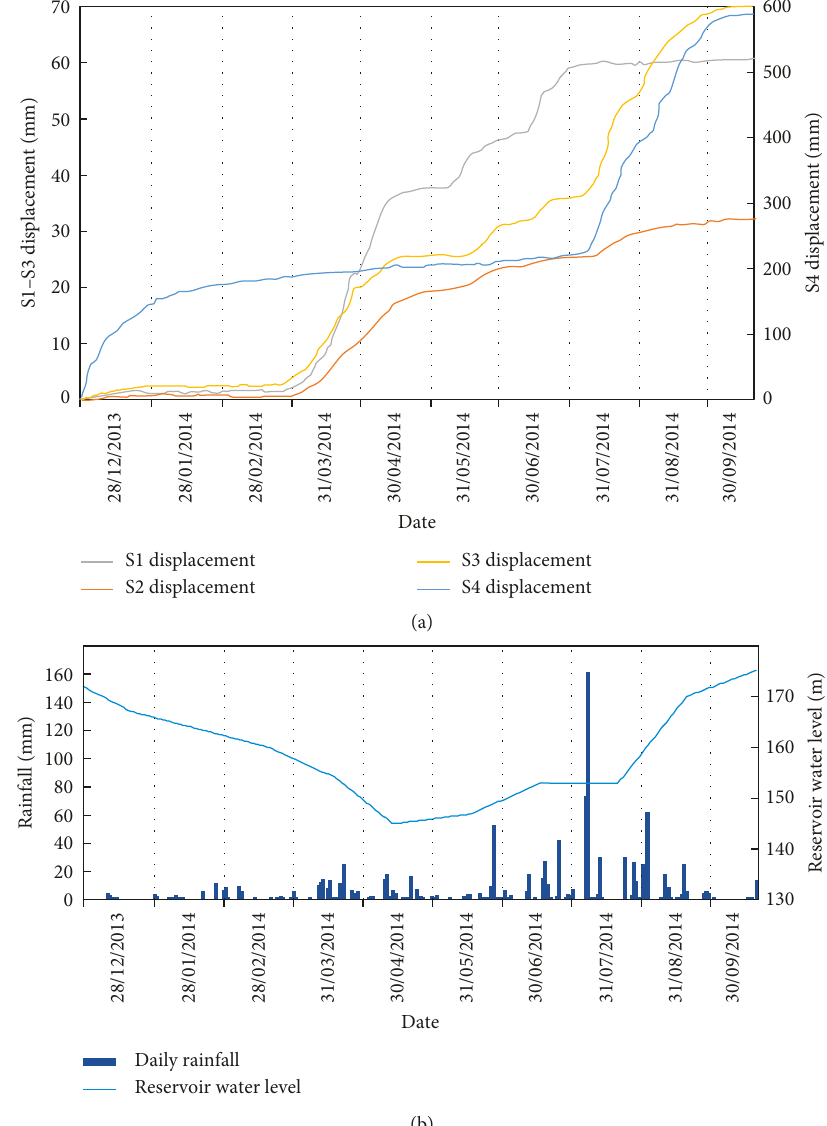
Figure 10: Surface displacement (a) and daily rainfall and reservoir water level (b) from December 28, 2013, to October 20,